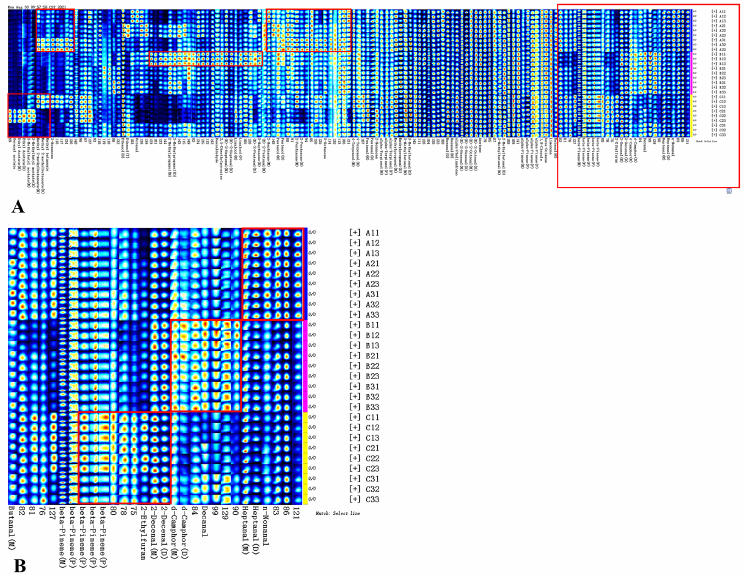
Figure 5. Fingerprints of the compounds isolated from AEOs from different regions using GC-IMS: A (Wenshan), B (Nujiang), C (Tengchong). ( A ) represents the fingerprint of all compounds detected by GC-IMS. ( B ) shows the enlarged fingerprint of compounds with obvious content differences among regions. Red represents high concentration, and dark blue represents almost not present. Increasing color darkness from dark blue to red depicts increasing